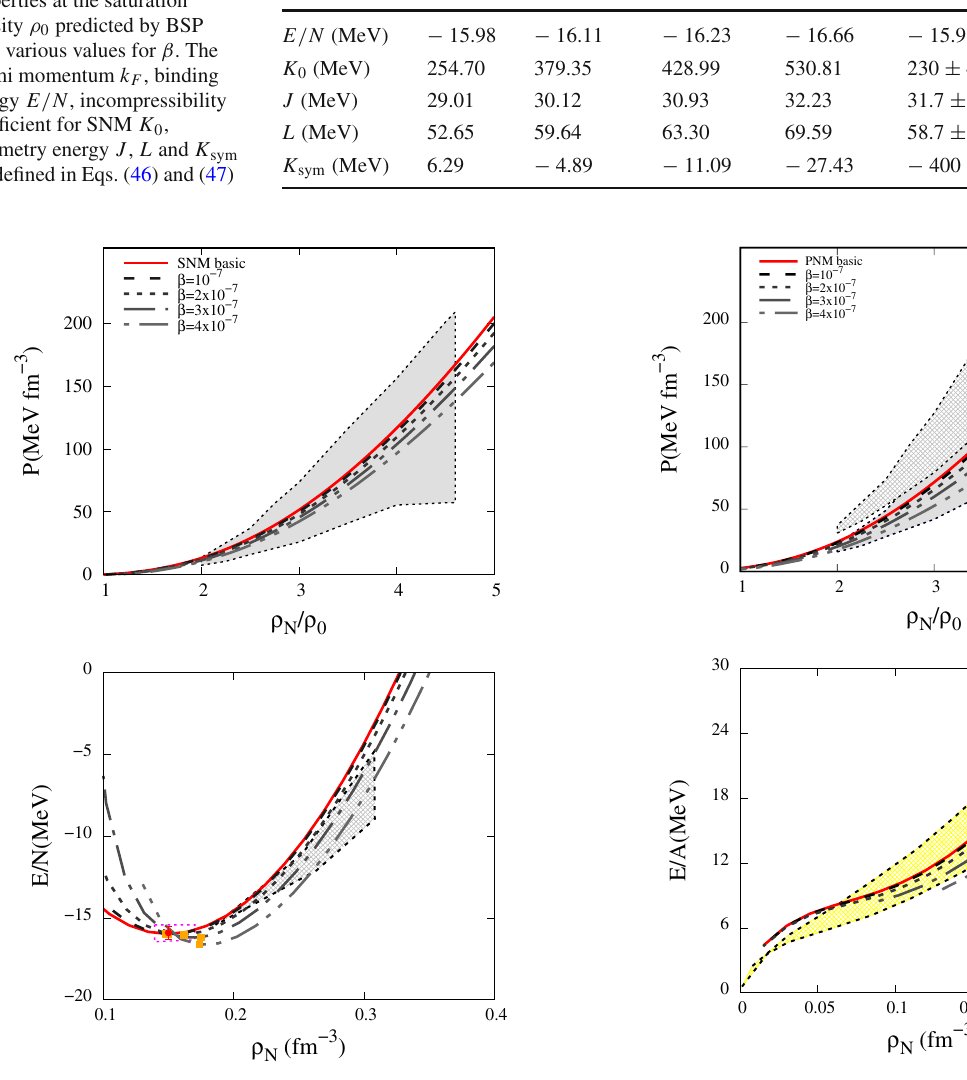
Fig. 2 Similar to Fig. 1, the results of varying β in the case of pure neutron matter (PNM). (Top) the dark and light grey shaded area is a heavy-ion experiment from [56]. (Bottom) the yellow shaded area is the theoretical binding energy from chiral effective field theory [57,58] is in agreement with a constraint from 87 Rb cold-atom-recoil experiment